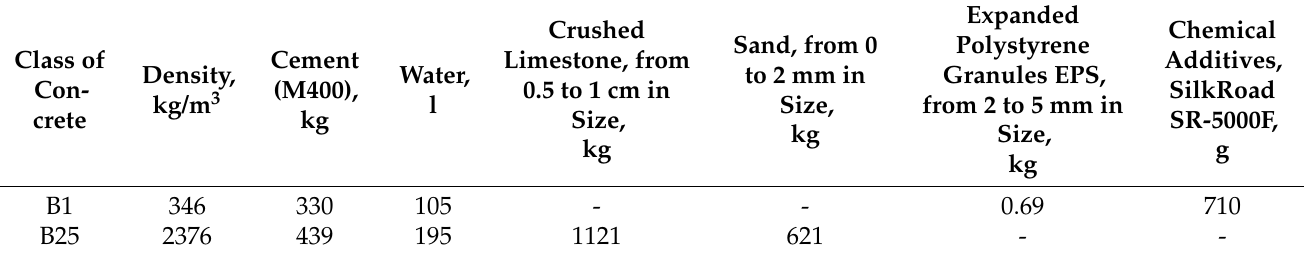
Table 1. Composition of concrete mixtures.